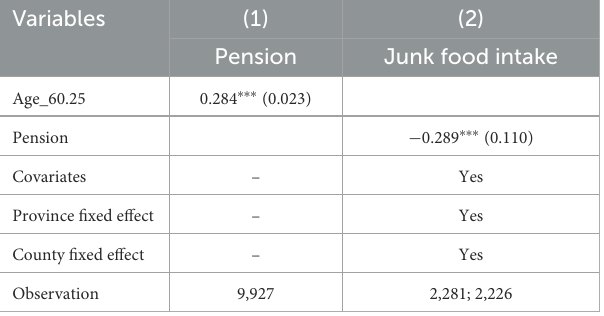
TABLE 4 The results of FRD